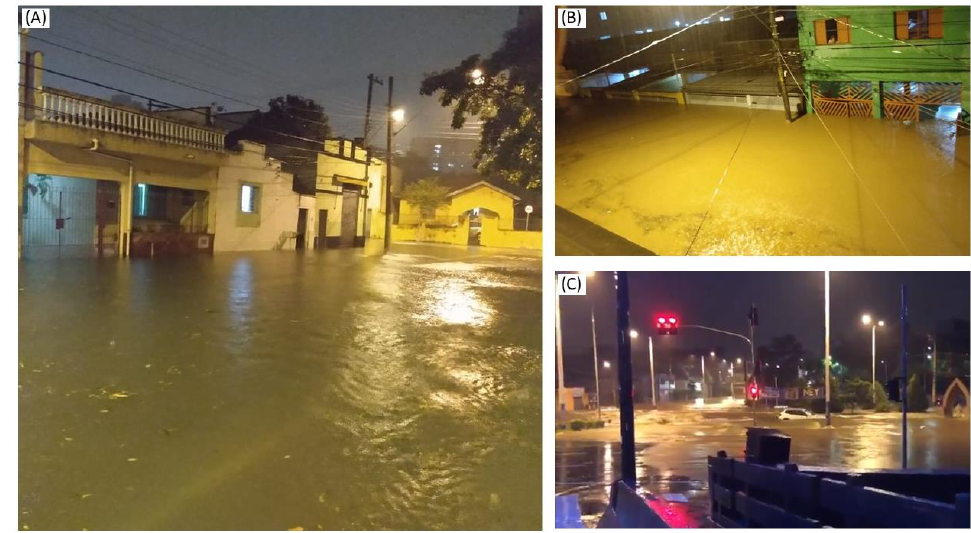
Figure 4. Some photos of the floods on 10 March 2019 in S ã o Caetano do Sul. Source: ( A , B ) [36]; ( C ) [37].